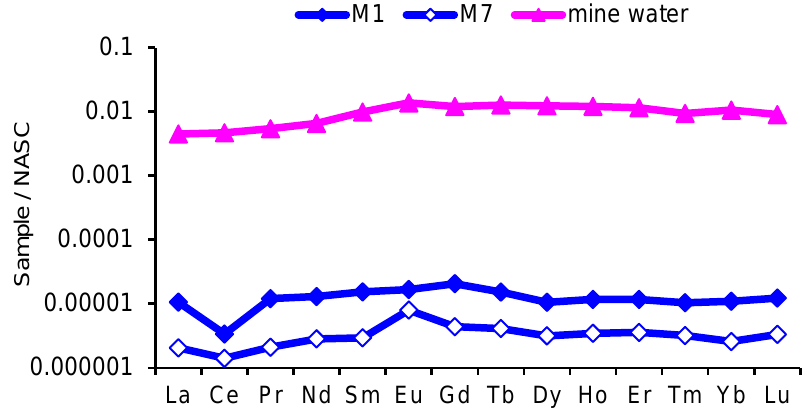
Figure 8. Normalized distribution of rare-earth elements in the river water Modonkul in the sites M1 and M7 and the mine water of the Kholtosonskoe deposit.